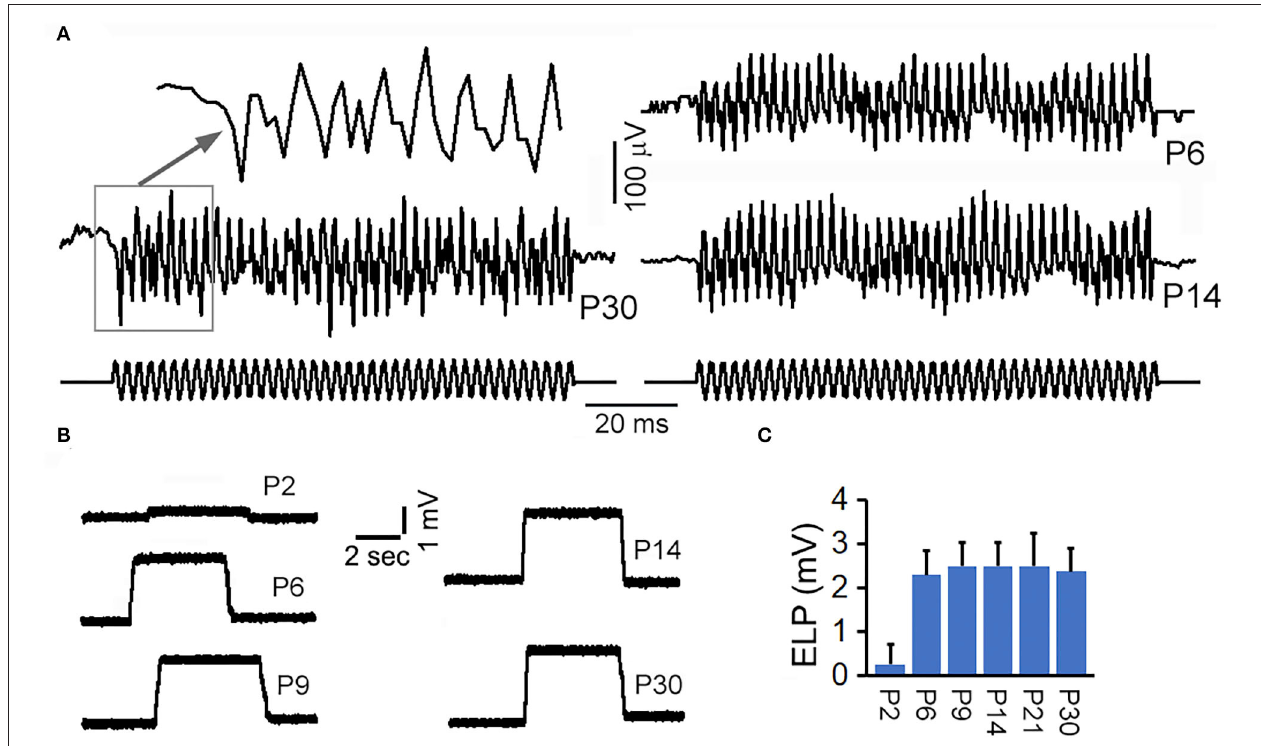
FIGURE 5 | Vestibular microphonic recorded from saccular macula and ELP recorded from semicircular canal. (A) Vestibular microphonic recorded from saccular maculae of neonatal and adult mice. (B) ELP recorded from semicircular canal of neonatal and adult mice. (C) Mean and SD of ELP from semicircular canal at different